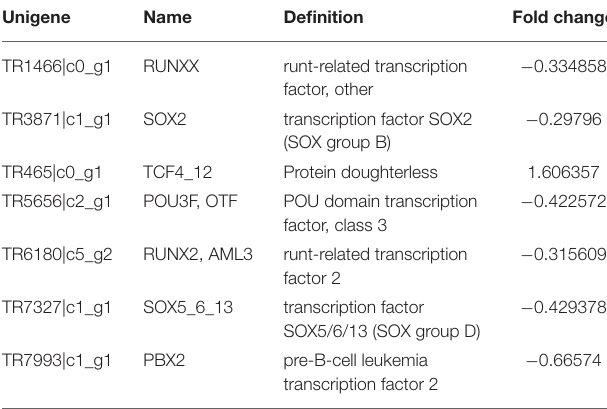
TABLE 4 | Transcription factor coding DEGs.